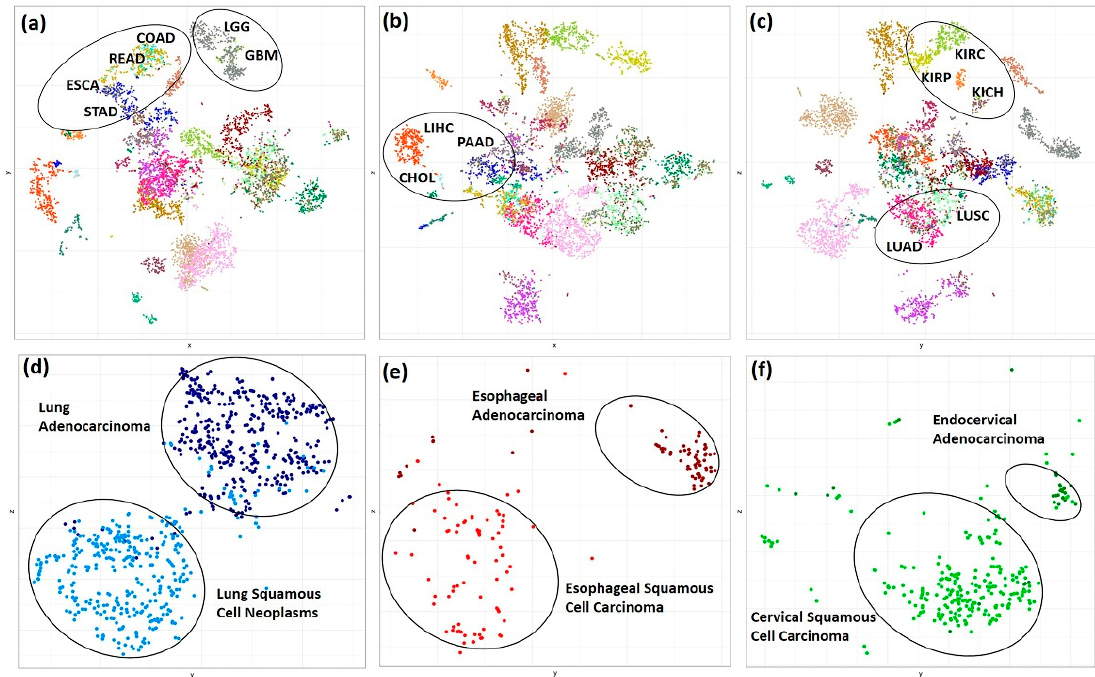
Figure 1. Distribution of the TCGA cancer samples in 2D t-SNE plot. ( a ) x vs. y ( b ) x vs. z ( c ) y vs. z coordinates for 6270 (combined kinase gene expression and promoter CpGs β values) features and 7783 TCGA tumor samples belonging to 30 cancer types. The mapped data points are colored as per the cancer types. ( d – f ) 2D t-SNE plot showing separation of TCGA Esophageal, Lung Carcinoma and Cervical Cancer into Adeno and Squamous histological tissue types based on combined kinase gene expression and methylation data of 930 samples which includes 71 esophageal adenocarcinoma, 80 esophageal squamous cell carcinoma, 414 lung adenocarcinomas, 365 lung squamous cell carcinoma, 246 cervical squamous cell carcinoma and 30 endocervical